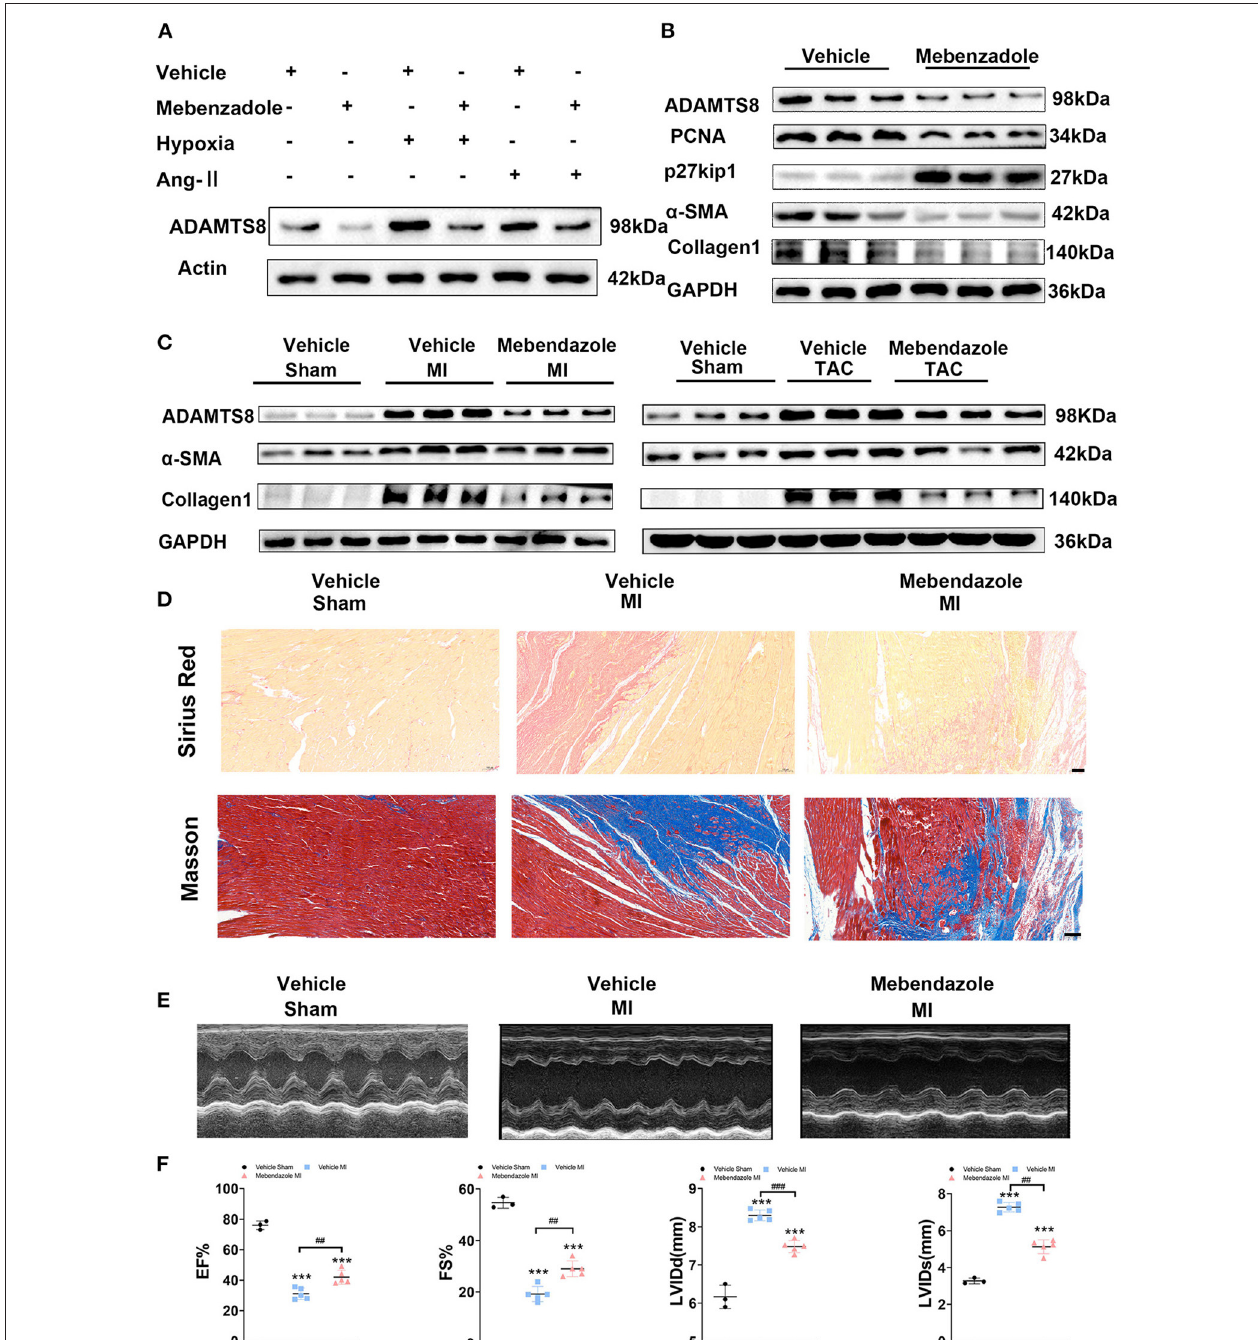
FIGURE 9 | Mebendazole down-regulated ADAMTS8 and ameliorated cardiac fibrosis and heart failure. (A) Representative Western blots and quantification of ADAMTS8 in cardiac fibroblasts treated with mebendazole (5 mol/L) for 48h ( n = 3 each). (B) Representative Western blots and quantification of ADAMTS8, PCNA, p27kip1, α -SMA, and Collage1 expression in CFs treated with or without Mebendazole ( n = 3 each). (C) Representative Western blotting of ADAMTS8, α -SMA, and Collagen1 protein levels in the LVs of rats followed by treatment with vehicle or mebendazole for 14 days after MI or TAC ( n = 5 each). (D) Representative pictures from Sirius red and Masson staining in the infarct border zone of rats followed by treatment with vehicle or mebendazole for 21 days after MI(scale bar = 100 µ m). (E,F) Representative M-mode echocardiograms obtained on 28th day post-MI. Cardiac function was measured by detecting EF%, FS%, LVDD, and LVSD post-MI. Data were presented as mean ± SEM. *** P < 0.001, ## P < 0.01 and ### P < 0.001 between the two indicated groups.